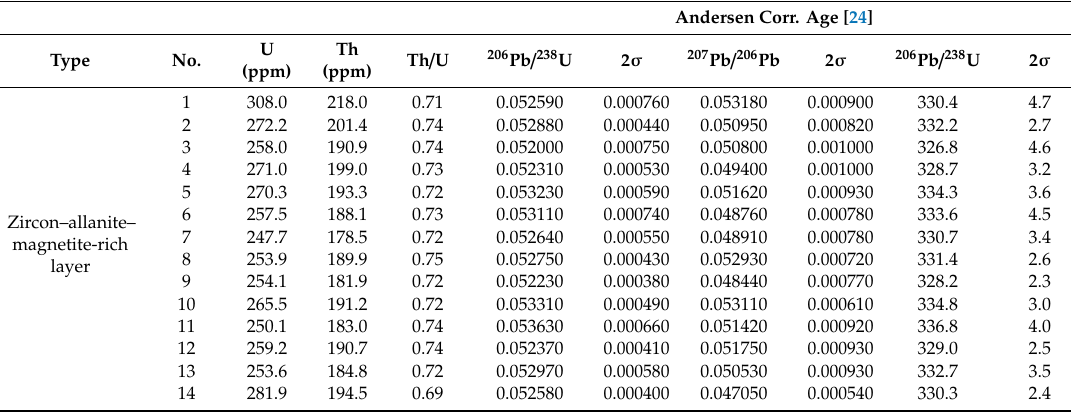
Table 1. Laser ablation multi-collector inductively coupled plasma mass spectrometry (LA-MC-ICP-MS) U–Pb–Th isotopic analytical data for zircon from zircon–allanite–magnetite-rich layers and alkali